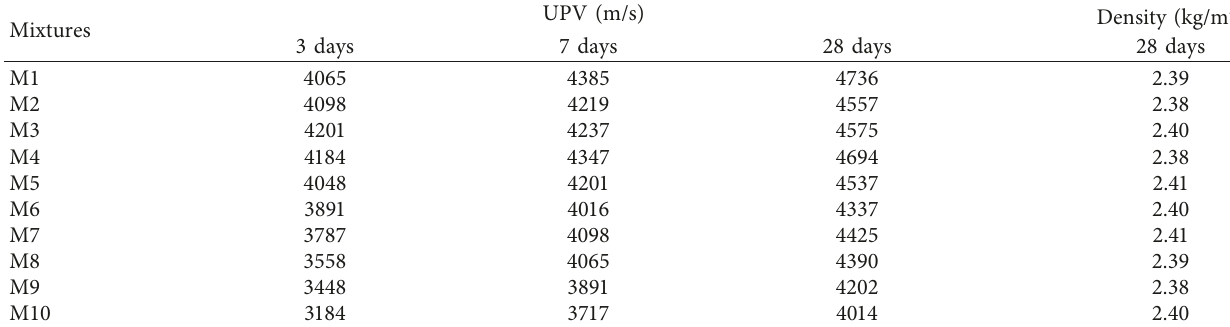
Table 5: UPV and density of the SCC